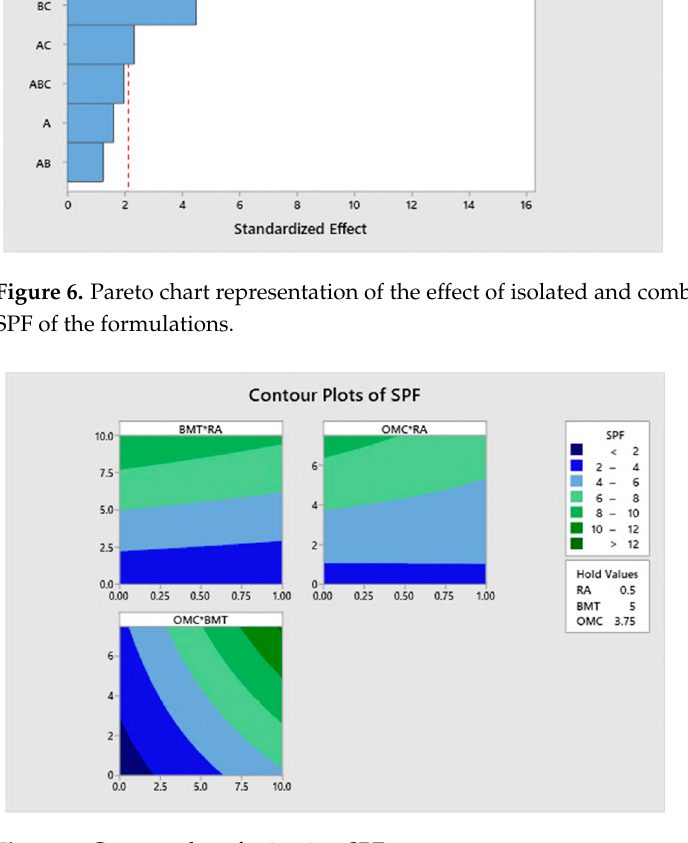
Figure 7. Contour chart for in vitro SPF.